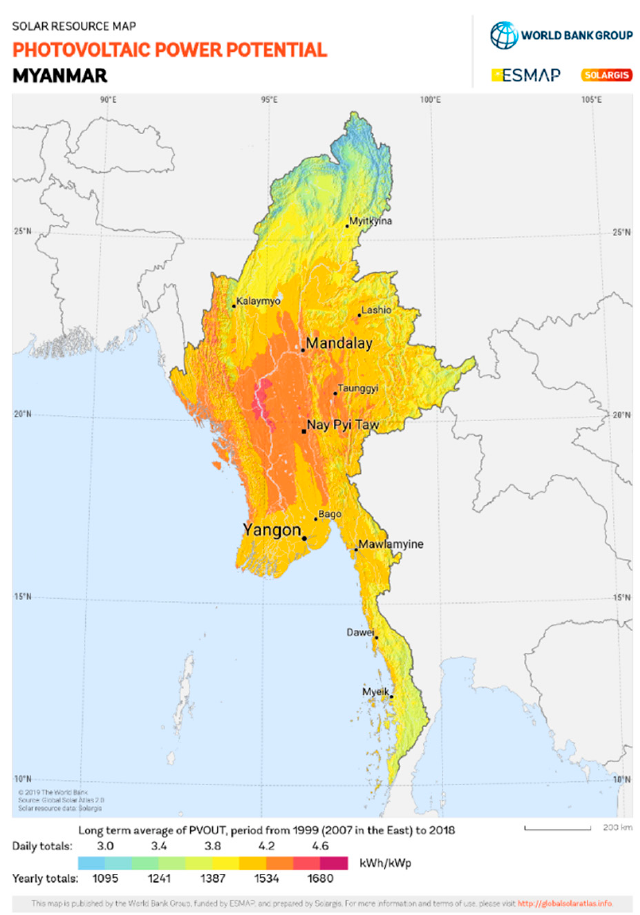
Figure 1. Photovoltaic Power Potential in Myanmar. Source: Global Solar Atlas 2.0, Solar resource data: Solargis. © 2019 The World Bank.